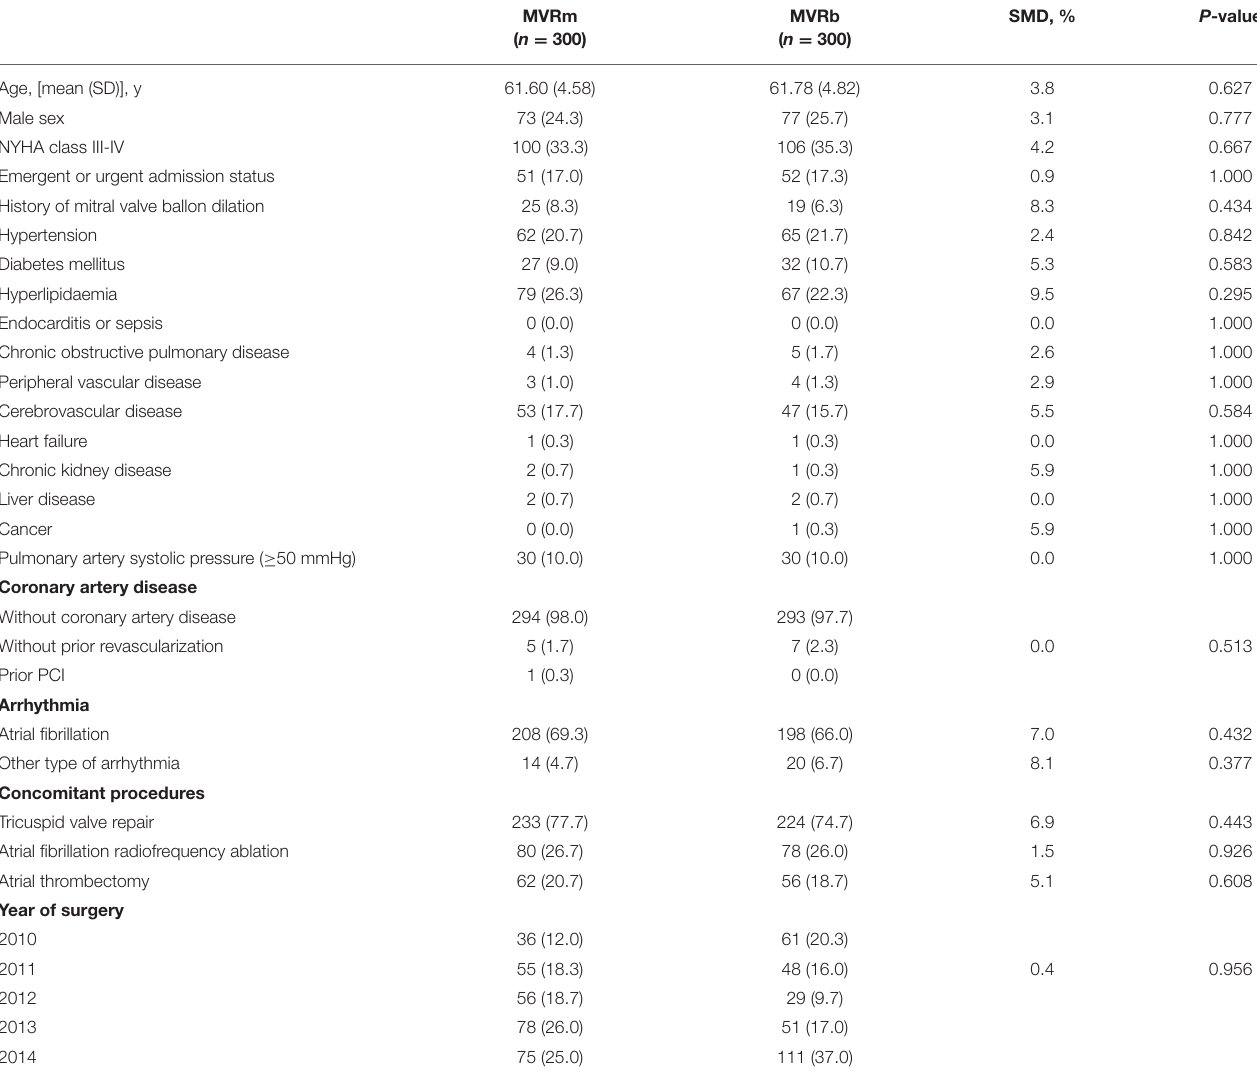
TABLE 2 | Baseline characteristics after propensity score